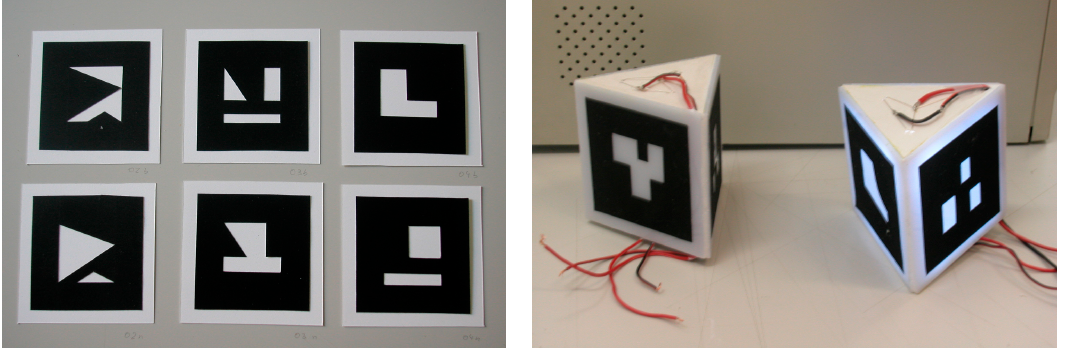
Figure 1. AR markers, for their use in applications built with ARToolKit.